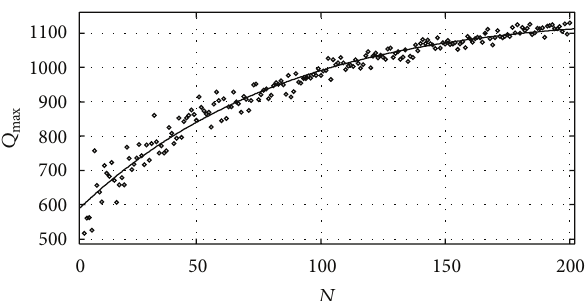
Figure 10: Relationship between 𝑄 max and 𝑁